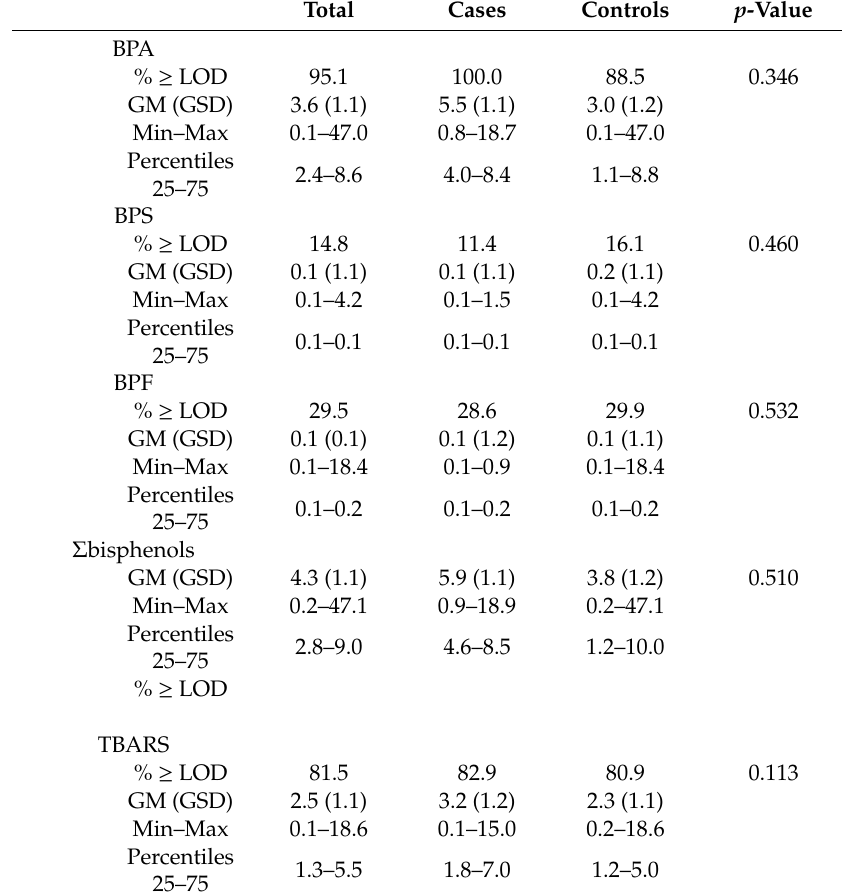
Table 2. Urinary levels of bisphenols and thiobarbituric acid reactive substances (TBARS) in the study population.